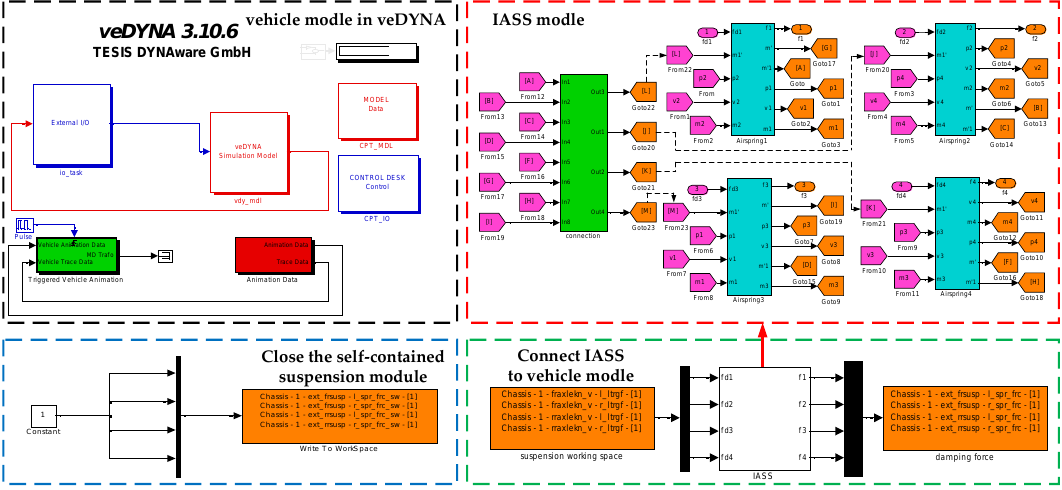
Figure 12. Vehicle model with IASS in veDYNA.